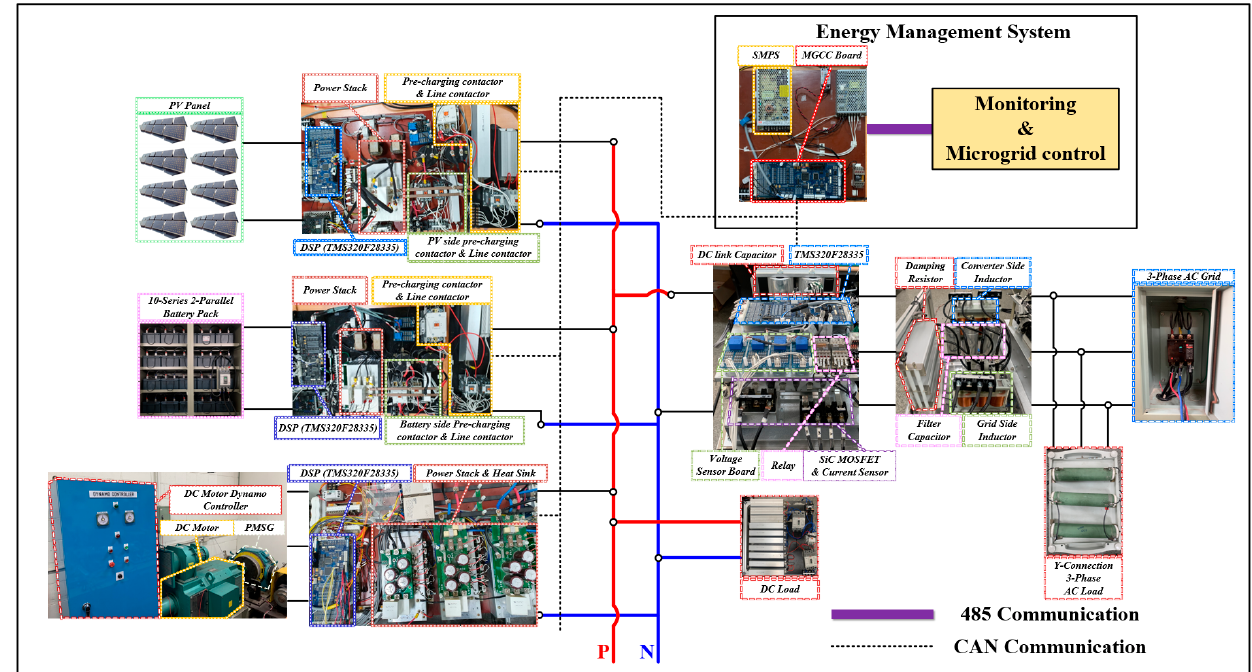
Figure 16. Experiment configuration of the hybrid AC/DC microgrid.